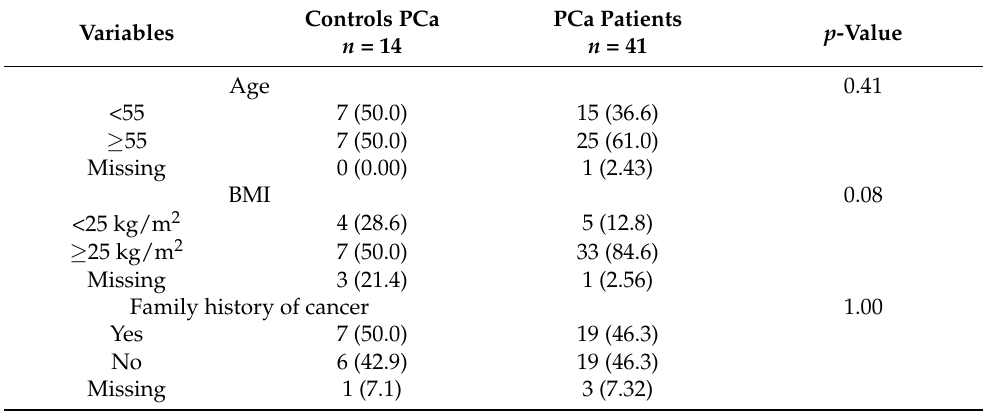
Table 1. Epidemiological characteristics of the study population of men with and without prostate